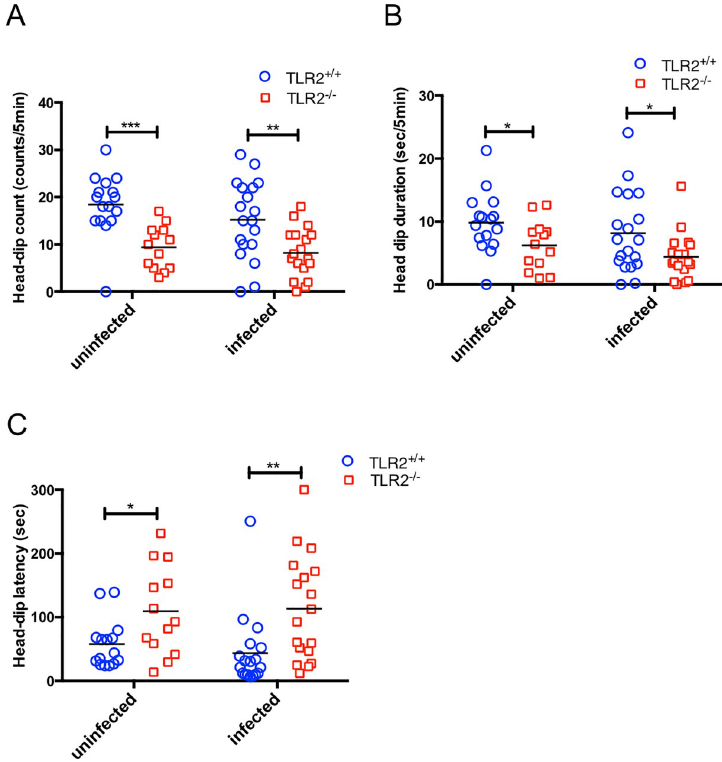
Fig 2. Effects of T . gondii infection on anxiety-related behavior in mice. Changes in the exploratory behavior at 31 days post infection: (A) head-dip count (counts/5 min), (B) head-dip duration (sec/5 min), and (C) head dip latency (sec). Data were summarized from two independent experiments (uninfected TLR2 +/+ , n = 16; uninfected TLR2 -/- , n = 13; infected TLR2 +/+ , n = 21; infected TLR2 -/- , n = 18). Significant differences among the four groups were analyzed by a two-way ANOVA followed by t tests ( � , p < 0.05; ��� , p < 0.01; ���� , p < 0.001), significant main effects are shown for (A) TLR2 deficiency [ F (1,62) = 25.30, p < 0.0001], (B) TLR2 deficiency [ F (1,62) = 8.996, p < 0.01], and (C) TLR2 deficiency [ F (1,60) = 13.83, p < 0.001]. The interaction between T . gondii infection and TLR2 deficiency was not statistically